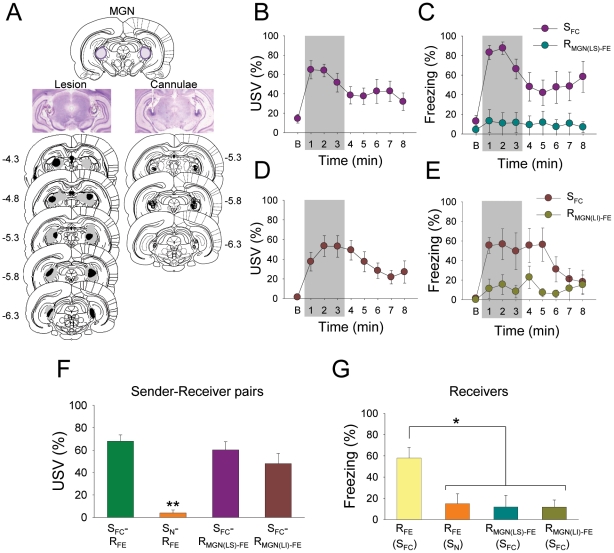
MGN lesion, MGN inactivation and social transmission of fear.(A) Photomicrograph and histological reconstruction of MGN lesions (solid and gray represent minimum and maximum extent of the lesions, respectively) and cannulae implantation (each dot represents the injection site in the MGN of the SFC (grey) - RMGN(LI)-FE (black) pair). (B, C) Mean percentage USV and freezing from SFC (n = 8) and MGN-lesioned receiver (RMGN(LS)-FE, n = 8) rats during the pair-testing. (D, E) Mean percentage USV and freezing from SFC (n = 7) and MGN-lidocaine receiver (RMGN(LI)-FE, n = 7) rats during the pair-testing. (F, G) Group differences in USV between SFC-RFE, SN-RFE, SFC-RMGN(LS)-FE, and SFC-RMGN(LI)-FE pairs (F
3,30 = 24.681, P<.0001) and freezing between fear-experienced receiver groups (F
3,30 = 5.770, P<.01) during the first 3-min period of the pair-testing (grey sections, B through E). * denotes P<.05 (Bonferroni test); ** denotes P<.001 compared to the other three pairs (Bonferroni test).